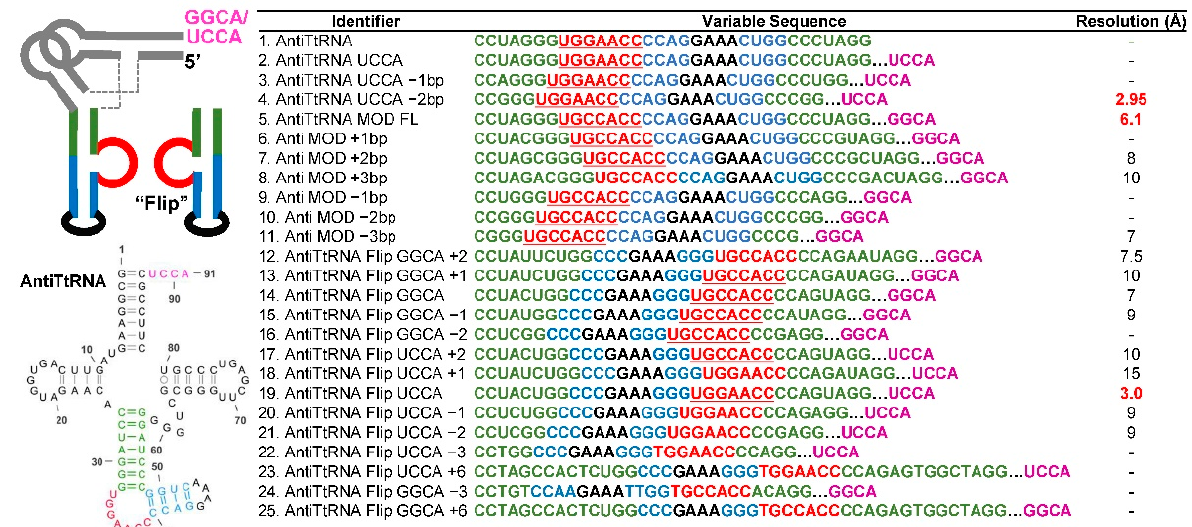
Figure 2. tRNA–antiterminator fusion designs. The core G. kaustophilus tRNA Gly structure remained consistent across designs with insertions restricted to the anticodon stem (green), colored as in the structural schematic (top) and secondary structure model (bottom, Construct #1, AntiTtRNA shown) on the left panel with the single-stranded bulge (red) either on the 5 ′ side or 3 ′ side of the inserted stem loop, capped by a GAAA tetraloop (black). The 3 ′ end of the tRNA also includes either a typical UCCA tail or an engineered GGCA tail (magenta). Resolution listed on the right column represents predicted diffraction limits from two orthologous diffraction images from crystals pulled directly from sparse matrix crystal screens (black font). Red font indicates crystal constructs for which full data sets were collected. A dashed line indicates constructs that either did not crystallize or did not yield crystals of sufficient quality for looping and testing.